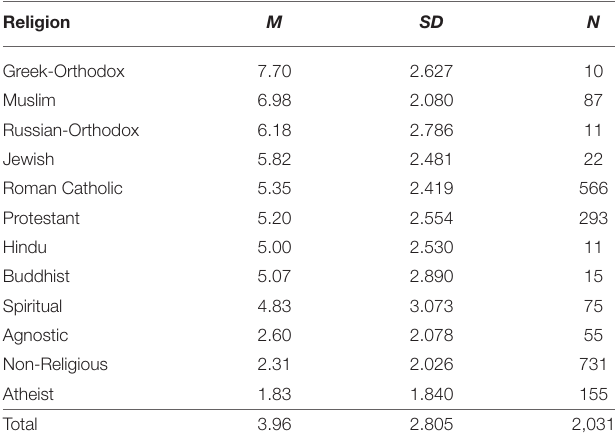
TABLE 2 | Means and SD of “religiousness,” split for people with various